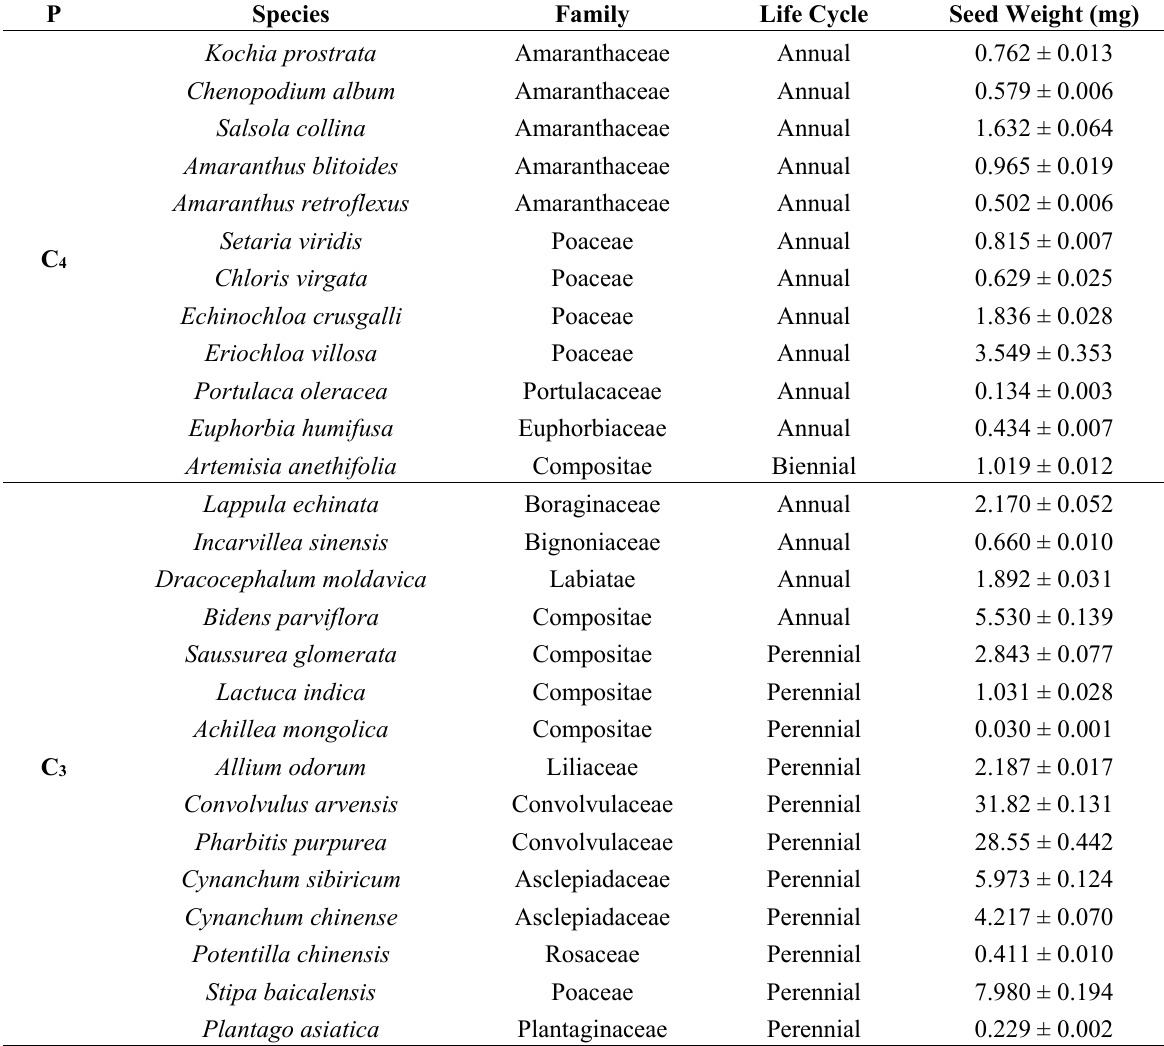
Table 1. Photosynthetic-type (P), family, life cycle, single seed weight (calculated from 30 seeds, n = 5) of 27 wild species in this